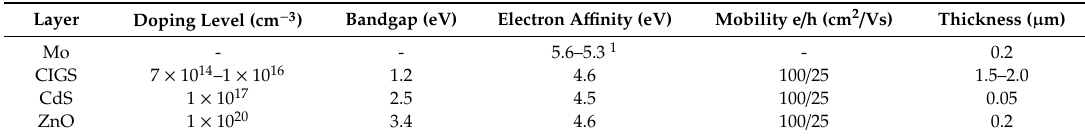
Table 1. Physical properties of each material layer in the simulation model.